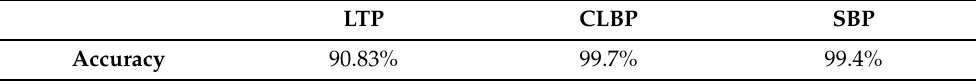
Table 5. Recognition test accuracy of the test carried out in BIT dataset employing LTP, SBP and CLBP.